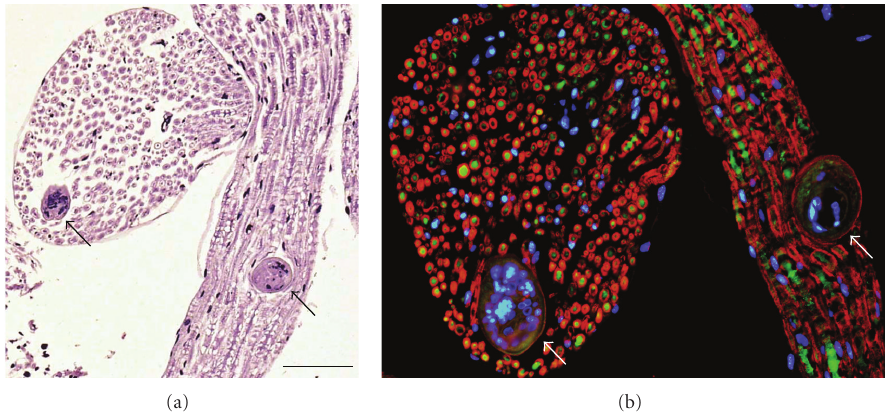
Figure 1: T. regenti schistosomula (arrows) migrating inside the peripheral nerve fascicles of an experimentally infected mouse: (a) haematoxylin and eosin staining, scale bar 100 μ m; (b) myelin sheets visualized by binding of anti-MBP (myelin basic protein) antibody and secondary anti-rabbit IgG-Cy3 (red), neurofilaments stained by anti-SMI-32 (neurofilament H nonphosphorylated) and secondary anti-mouse IgG-Alexa Fluor (green), cell nuclei stained by DAPI (4 (cid:2) ,6-diamidino-2-phenylindole) (blue).